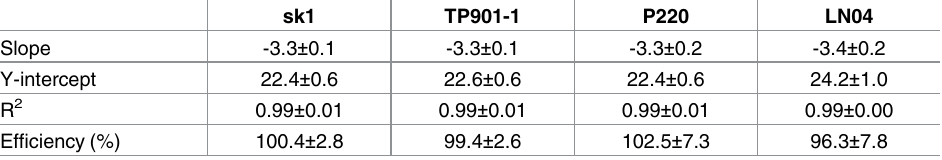
Table 3. Performance of qPCR assaysas components of the high-throughput